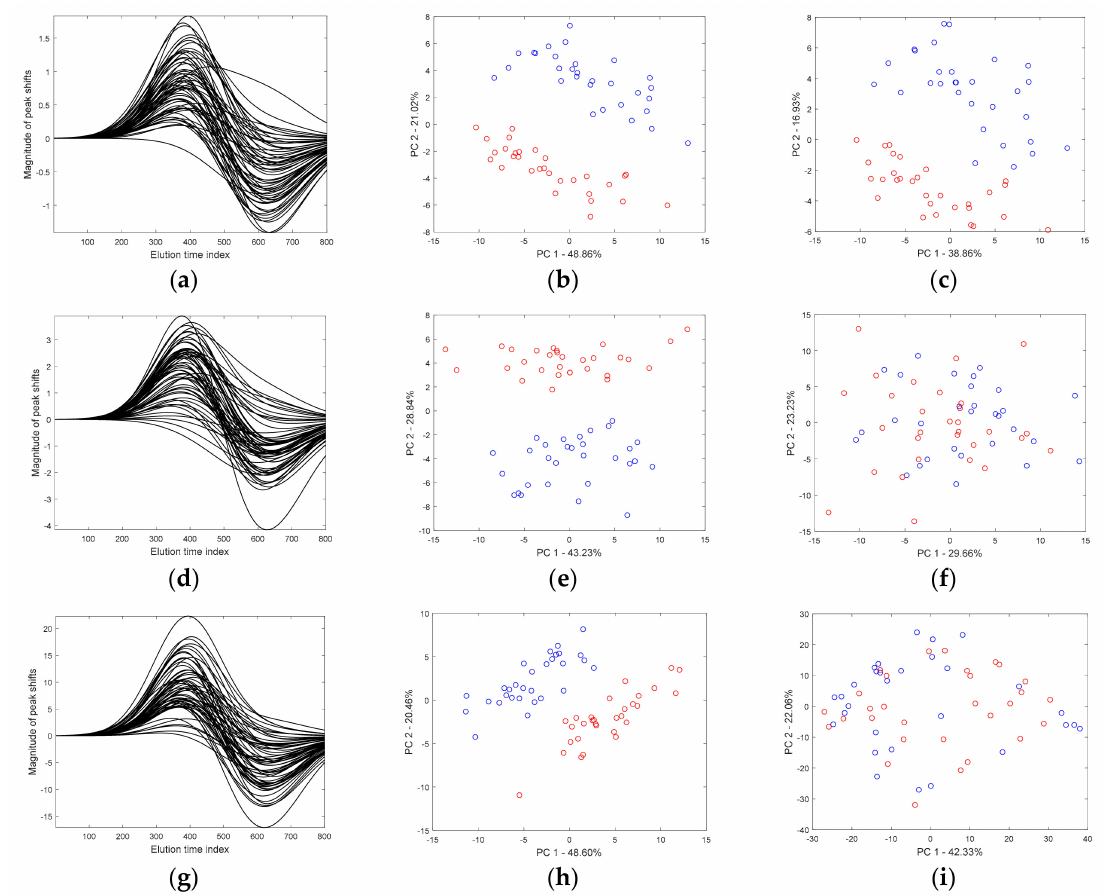
Figure 4. Simulated three sets of chromatographic signals containing two groups of samples. ( a , d , g ) warping functions. ( b , e , h ) projections of scores constructed using the Gram PCA approach on the space of the first two principal components for data without peak shifts. ( c , f , i ) the corresponding projections but for data with peak